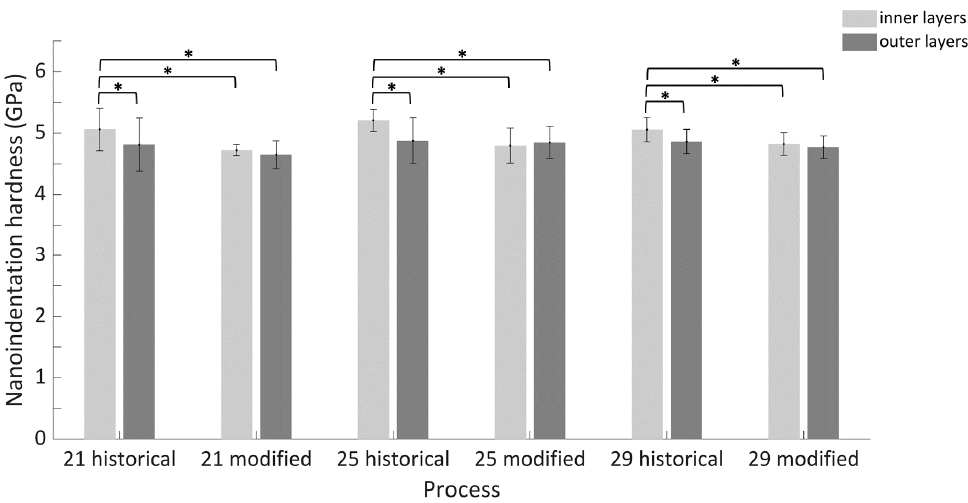
Figure 9. Mean values of nanoindentation hardness, for the inner layers and the outer layers. On the abscissa the diameter (mm) of the orifice and the deposition method. Where the * indicates significant differences between the mean values (p < 0.05). The reported values agree with those found in the literature